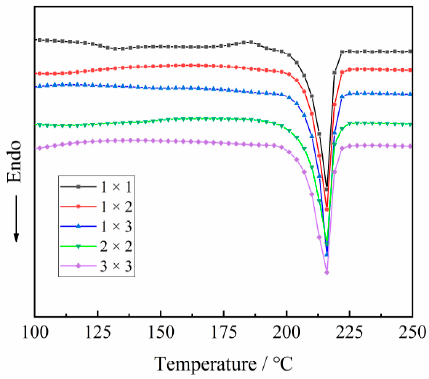
Figure 7. The first heating curve of the stretched PA510/SiO 2 films. Table 1. DSC data for the first heating thermograms for PA510/SiO 2 films.